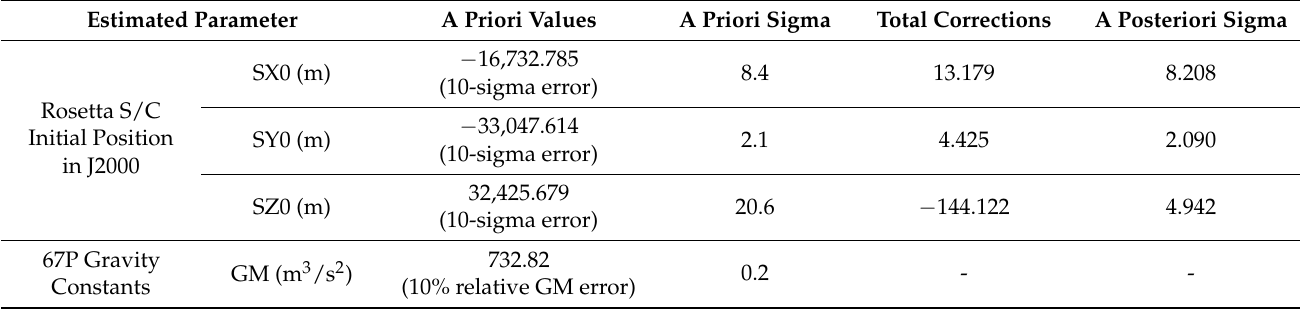
Table 10. Evaluation of navigation accuracy (case B). Parameter corrections and associated formal errors for the least-squares fit with a 10% relative error on the GM value. Post-fit orbit residuals are given in Table 9, second column. The other parameters are kept constant to the values found in Tables 6 and